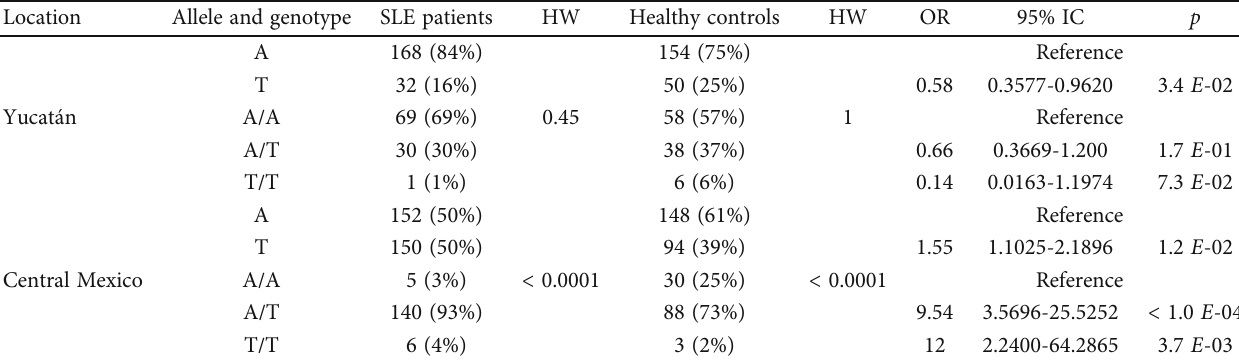
Table 2: Association analysis of the allelic and genotypic frequencies of rs179008 (A > T) in SLE patients and healthy controls from Yucatán and Central Mexico.